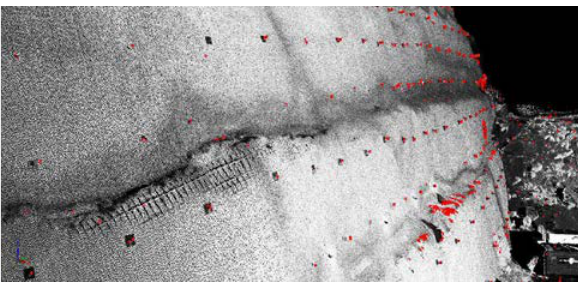
Figure 8. Results for rock bolts detection. The false positives are mainly located out of the slope of interest. Figure 9. Point cloud registration based on rock bolt locations. Points registered after the initial geometric procedures (grey) are transformed by ICP (purple) and registered to previous points (teal).